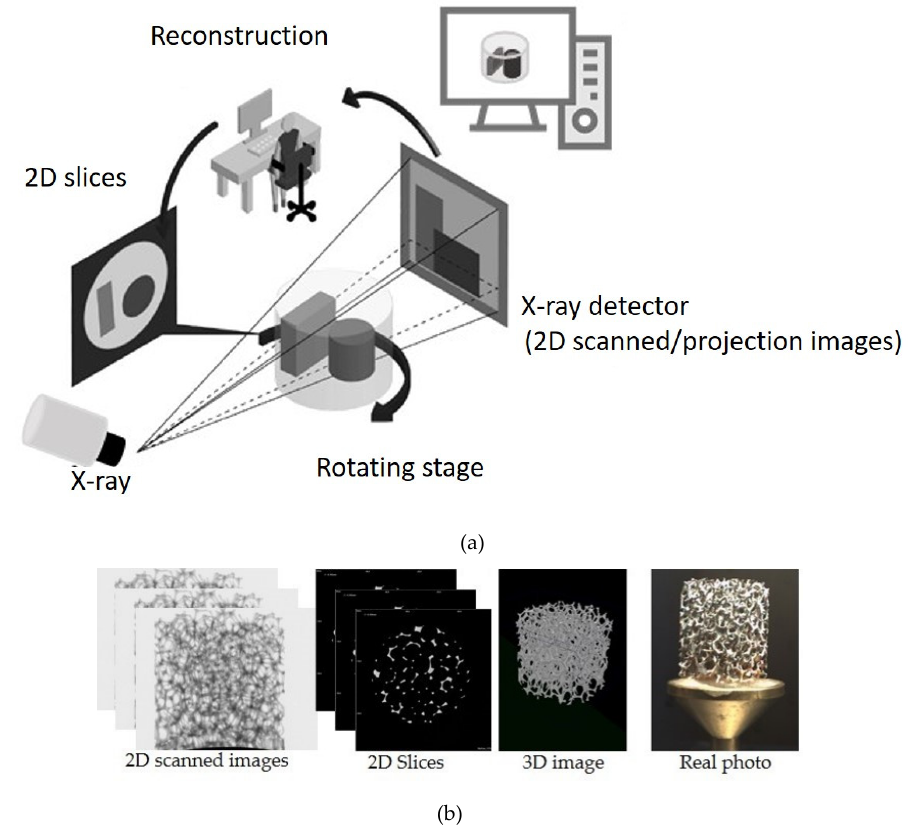
Figure 3. Scheme of the X-ray microcomputed tomography ( μ CT) equipment and an open-cell Figure3. SchemeoftheX-raymicrocomputedtomography( µ CT)equipmentandanopen-cellaluminum aluminum foam (height: 20.4 mm; diameter: 18.9 mm) ( a ) and showing and showing raw foam (height: 20.4 mm; diameter: 18.9 mm) ( a ) and showing and showing raw scans / projections, scans/projections, segmented images, reconstructed structure, and real photo ( b ). segmented images, reconstructed structure, and real photo ( b